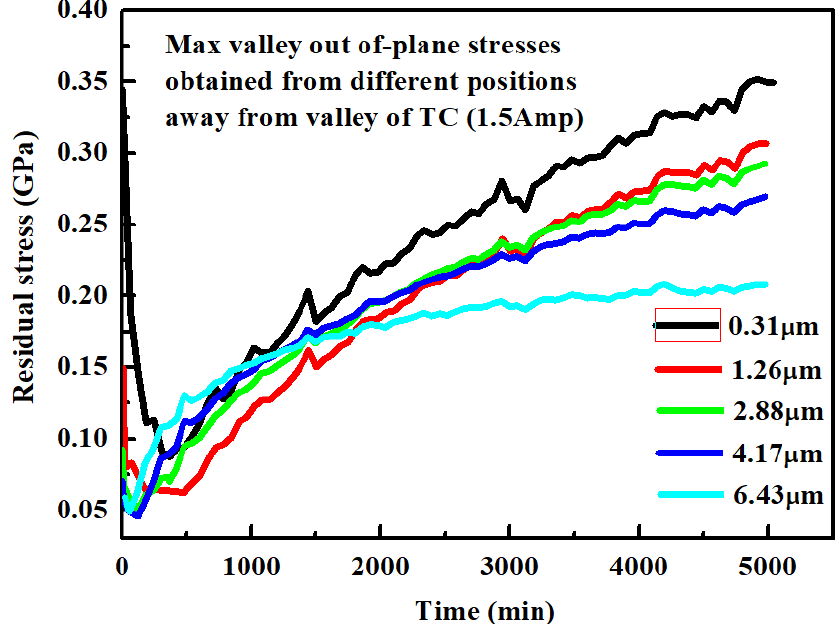
Figure 36. Out-of-plane residual cooling stresses calculated at the valley of TC as a function of time with several selected positions using 1.5 A roughness amplitude.